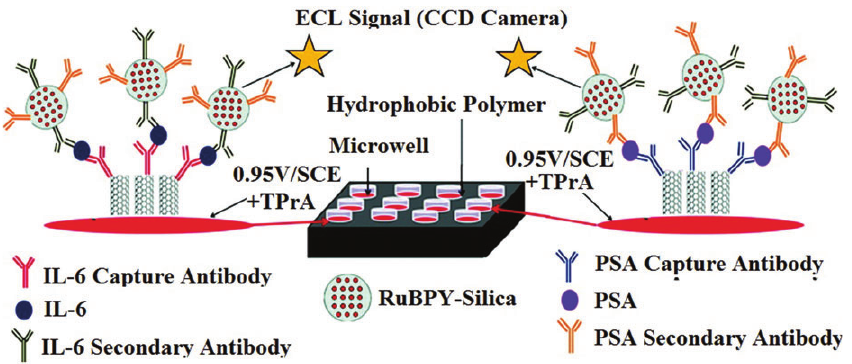
Figure 3 Carbon nanotube microwell array for sensitive electrochemiluminescent detection of cancer biomarker proteins. (Reproduced with permission from Sardesai et al. 2011